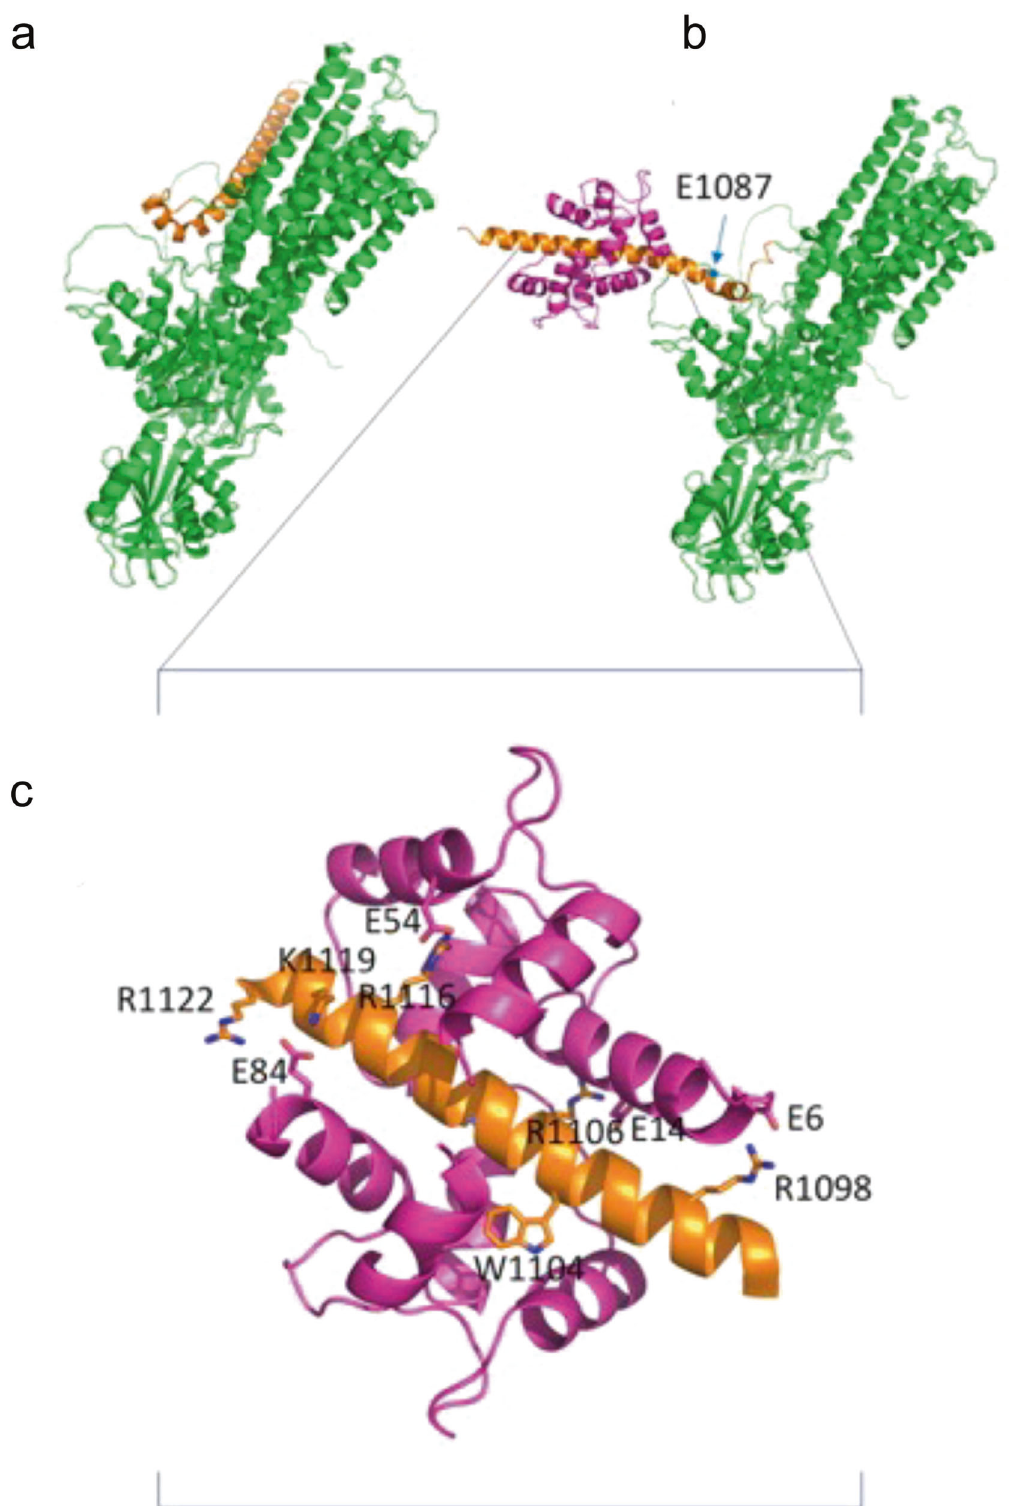
(immuno fl uorescence and ER Ca 2 + ) or 6-multiwell plates (western blot and cytosolic Ca 2 + ) are allowed to grow to 70 – 80% con fl uence before transfection. Transfection was performed with the Ca 2 + phosphate procedure (4µg of total DNA for 13mm coverslip and 12µg/well for the 6-multiwell plate. For Ca 2 + measurement cells were co-transfected with aequorin constructs targeted to different cell compartments (cytAEQ, erAEQ) and pcDNA3 empty vector or short/long PMCA3 wild type/mutated